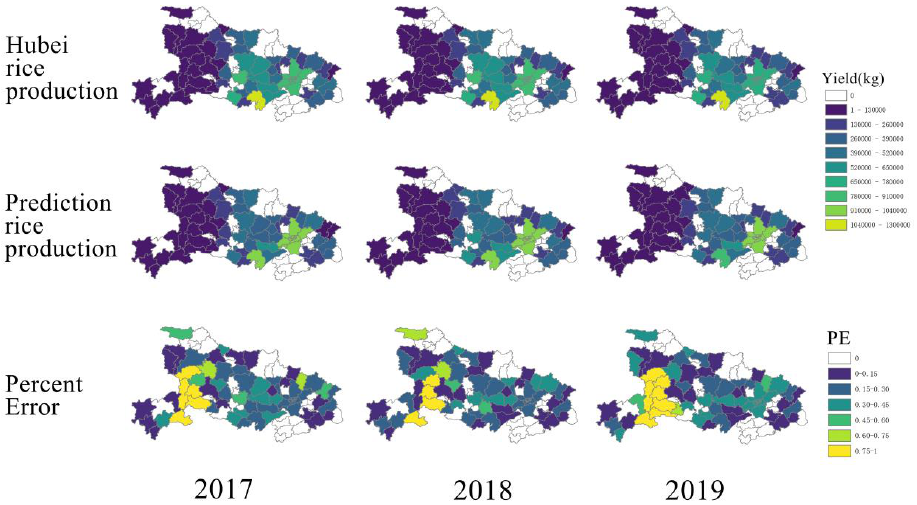
Figure 6. Map of rice production in Hubei Province, projected production and percentage error (PE) 390